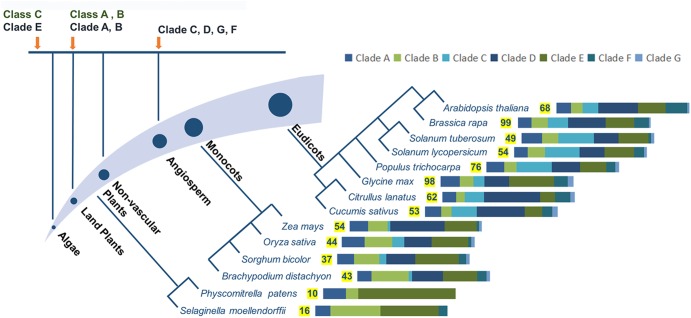
Evolutionary analysis of PG genes, numbers of family members, and proportions of different clades in representing species. Different clades or classes emerged at different periods during evolution, with appearance times indicated by orange arrows. PG family members are shown for different species of land plants, with significant changes in the proportions of different clades. Different bar lengths represent different proportions of clades. The numbers of family members in representative species are from reported studies (Tyler et al., 2010; McCarthy et al., 2014; Sénéchal et al., 2014; Yu et al., 2014; Liang et al., 2015, 2016) with some modifications.